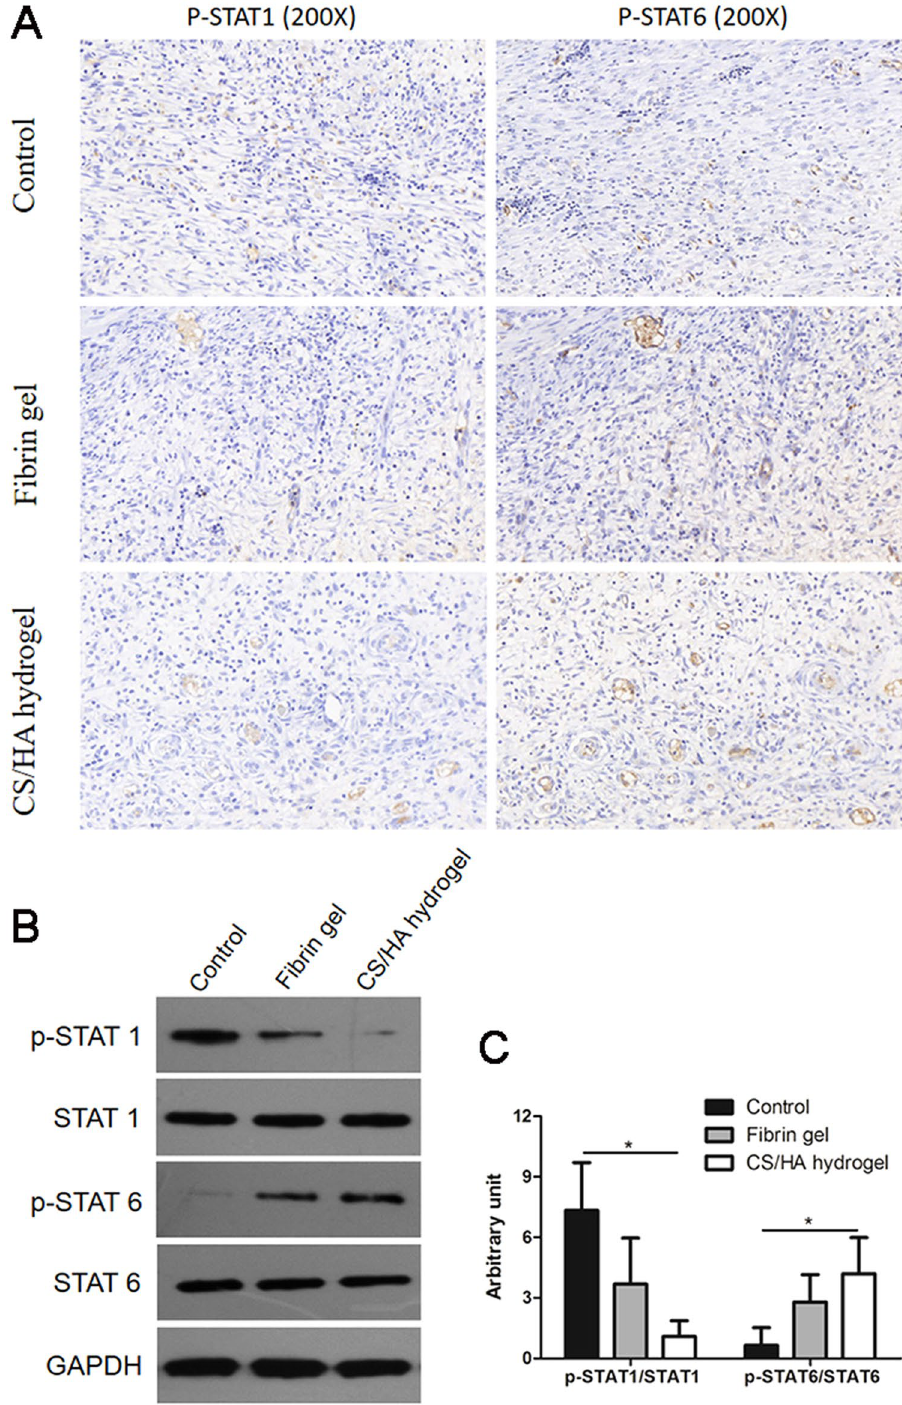
Figure 7. ( A ) Expression of p-STAT1 and p-STAT6 in the regenerative tissue was determined by immunohistochemistry. The amplification was 200 × . ( B ) Representative western blot images (cropped) of expression of p-STAT1, STAT1, p-STAT6 and STAT6 in the regenerative tissue. ( C ) Gray intensity of p-STAT1 and p-STAT6 was analyzed. * P <